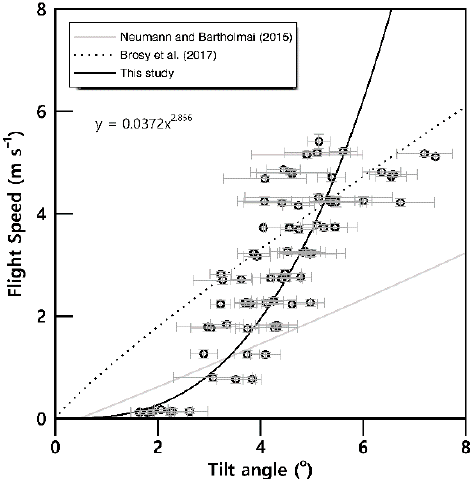
Figure 6. Regression function of the relationship between flight speed and tilt angle as experimentally determined during calm wind conditions ( < 1 m s − 1 ). The solid black line represents the fitted regression function and the gray error bars indicate standard deviations.